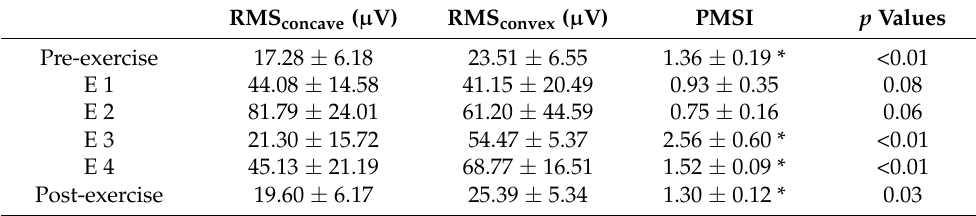
Table 2. Paraspinal muscle symmetry index (PMSI) before, during and after Schroth Exercise ( n = 9). RMS concave ( µ V) RMS convex ( µ V) PMSI p Values Pre-exercise